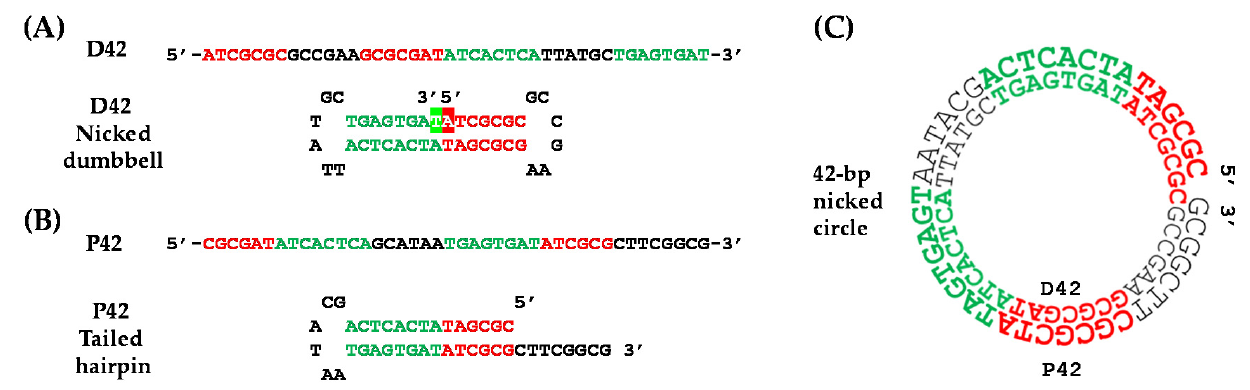
Figure 1. Sequence and schematic representation of the ( A ) D42 and ( B ) P42 ssDNA oligonucleotides that were used in the ligation and circularization experiments to give rise to a ( C ) 42-bp dsDNA microcircle and have been simulated in the present work.